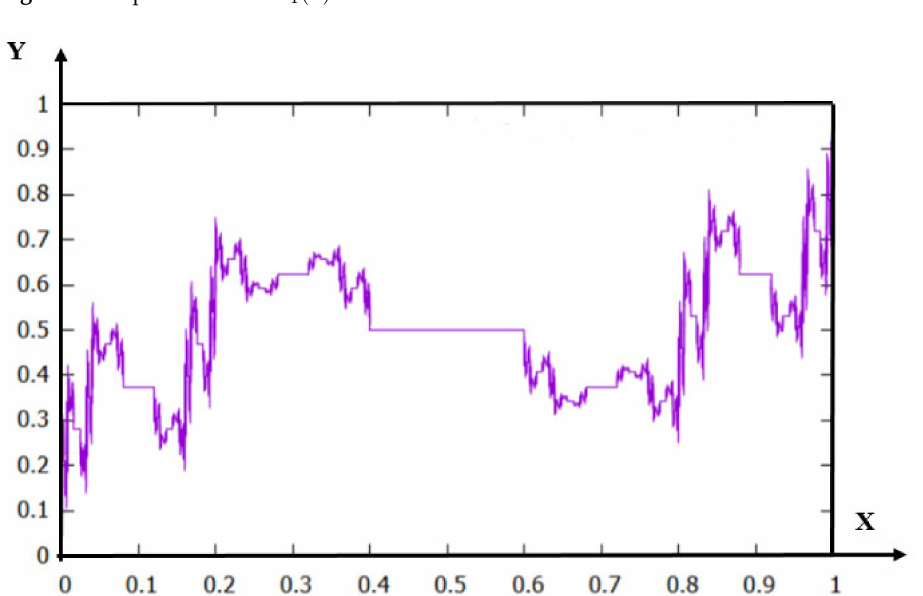
Figure 9. Graph of function F 1 ( x ) .